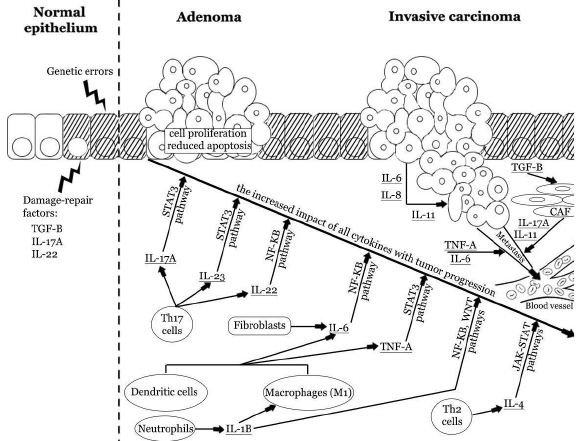
Figure 2. The impact of pro-tumorigenic cytokines in colorectal carcinogenesis. Repetitive colorectal mucosal damage may induce chronic immune system activation and injury of epithelial cells. These processes stimulate cellular augmented proliferation and regeneration, which in turn may result in the accumulation of genetic errors. Inflammatory cytokines may promote tumor formation and en- hance progression from adenoma to invasive carcinoma. Cytokines produced by innate and adap- tive immune cells and fibroblasts promote cellular proliferation and reduce apoptosis. The latest reports indicate the strong role of IL-17A, IL-6, and TNF- α. These cytokines have an increased im- pact at different stages of CRC progression. Cancer cells can also produce some cytokines and en- hance the vicious cycle of inflammatory response. Finally, cytokines can induce angiogenesis, stro- mal reorganization, suppression of antitumor immunity, and metastasis [2,29,41,50 – 53]. IL — inter- leukin; Th — T helper cell; TNF-A —tumor necrosis factor α; TGF - β—tissue growth factor β. 4.1. IL- 1β IL- 1β is a member of the interleukin-1 family. This cytokine is produced by activated macrophages as a proprotein, which is then proteolytically processed by caspase 1 to its active form. IL- 1β can also be secreted by immune, stem, and tumor cel ls. In that case, it partakes in immunomodulation of TME and can facilitate the immune surveillance escape mechanism [54]. IL- 1β mediates cell proliferation, differentiation, and apoptosis, but also induces the proinflammatory response by stimulating the e xpression of TNFα, IL -6, IL-8, IL-17, COX-2, and PGE 2 [52,54]. However, the role of IL- 1β in CRC carcinogenesis is still not fully explained. Interleukin 1β is overexpressed in both the epithelial and metastatic CRC, and its increased level has been associated with increased CRC growth and invasion [55]. It is most likely caused by the stimulation of metalloproteinase release from the tu- mor microenvironment, which are the mediators of tissue damage and degradation. IL- 1β induces ZEB1, a mediator of EMT form ation, and ICAM-1 expression, which promotes adhesion and self-renewal of cancer stem cells (CSC) [54,56,57]. Carcinoma cell-derived IL- 1β can then induce PGE 2 secretion by mesenchymal stem cells (MSC) and enhance